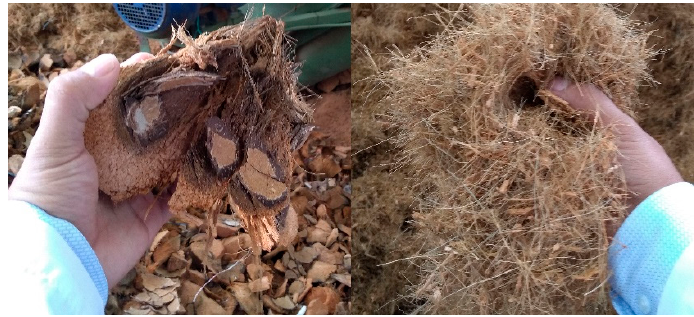
Figure 1. Raw coir coconut.